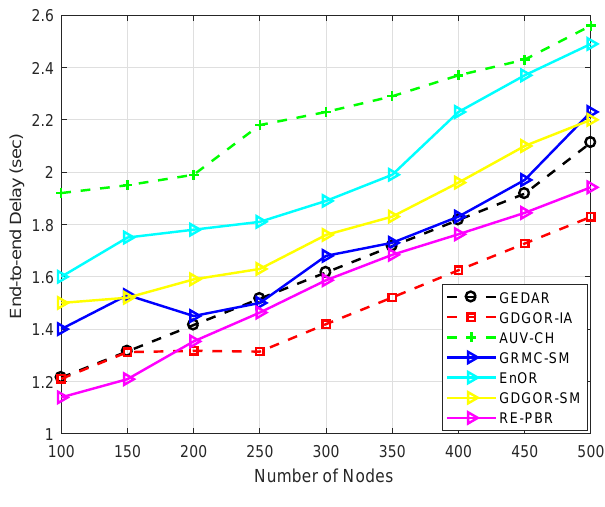
Figure 12. End to end delay plots. Table 3. Analysis of performance parameters against